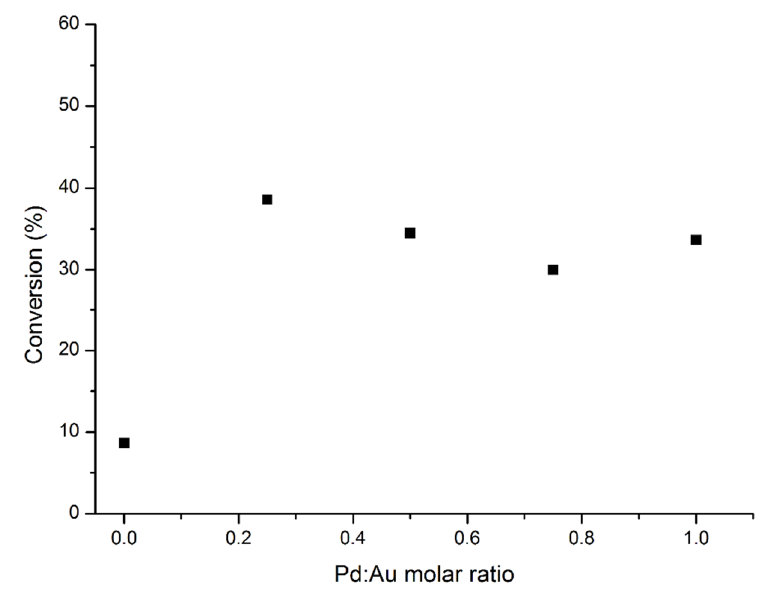
x Pd y -TiO 2 catalysts.